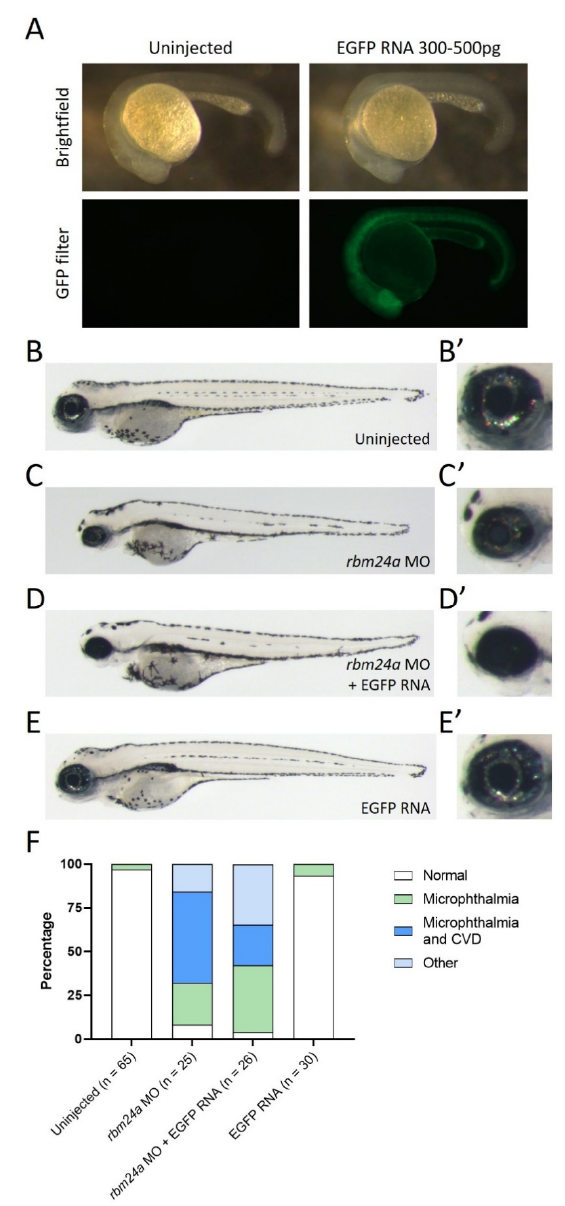
Figure 3. EGFP RNA does not suppress rbm24a knockdown. ( A ) Uninjected and EGFP RNA-injected 1 dpf embryos are shown in both brightfield (top) and with a GFP filter (bottom). ( B ) Uninjected 4 dpf embryo with wild type morphology, ( B’ ) detail of eye in B. ( C ) rbm24a knockdown embryos display microphthalmia with cardiac edema, ( C’ ) detail of eye in C. ( D ) Sequential injection of rbm24a morpholino and EGFP RNA yields phenotypes similar to knockdown alone, ( D’ ) detail of eye in D. ( E ) EGFP RNA-injected embryos are morphologically wild type, ( E’ ) detail of eye in E. ( F ) Graph of phenotypes. Image A taken at 62 × . Images B-E’ taken at 33 ×